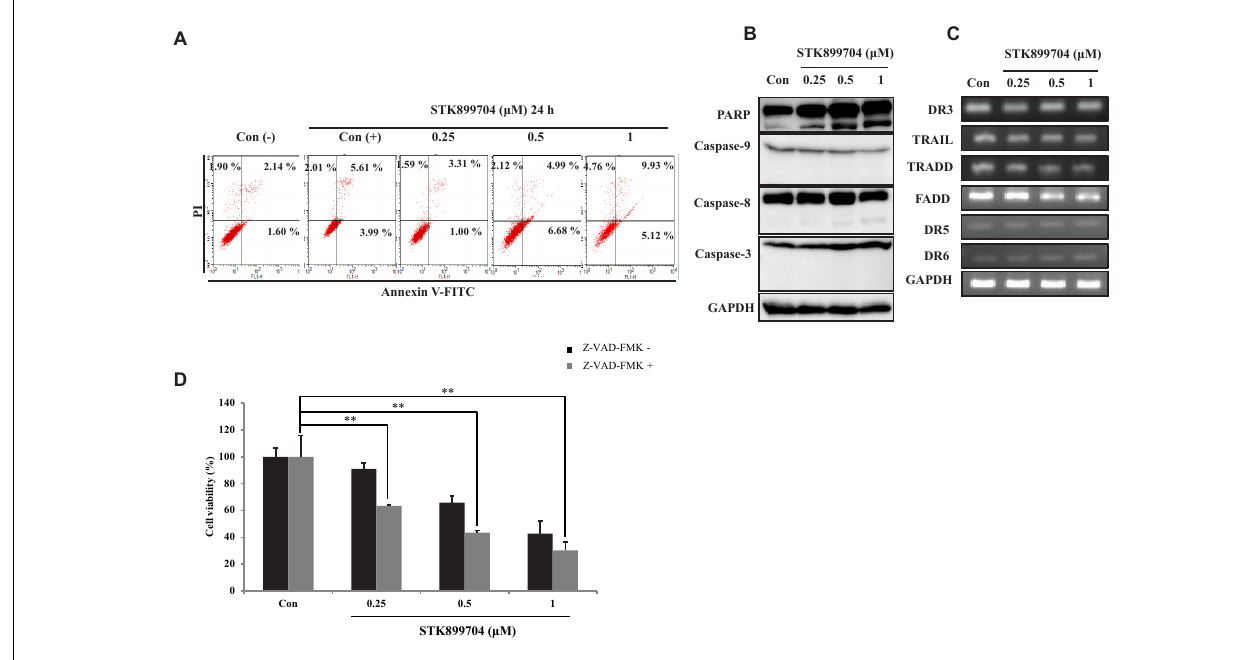
FIGURE 4 | Effect of STK899704 on apoptosis in A549 cells. Effect of STK899704 on apoptosis in A549 cells. A549 cells were treated with STK899704 for 24 h in a dose-dependent manner. (A) Apoptotic cells were determined by performing annexin V-PI staining by FACS. Quadrant 1 contains late apoptotic cells (annexin V and PI positive), and quadrant 4 contains early apoptotic cells (annexin V positive and PI negative). (B) Western blotting was performed to measure the levels of apoptosis-related proteins. GAPDH was used as an internal control. (C) The mRNA levels of genes encoding death receptors and their ligands were analyzed by performing Reverse transcription polymerase chain reaction (RT-PCR). GAPDH was used as an internal control. (D) A549 cells were treated with STK899704 with Z-VAD-FMK (total caspase inhibitor) for 24 h. Cell viability was determined by performing CCK-8 assay. Data are presented as mean ± standard deviation ( n = 3). ∗∗ P < 0.005 versus control